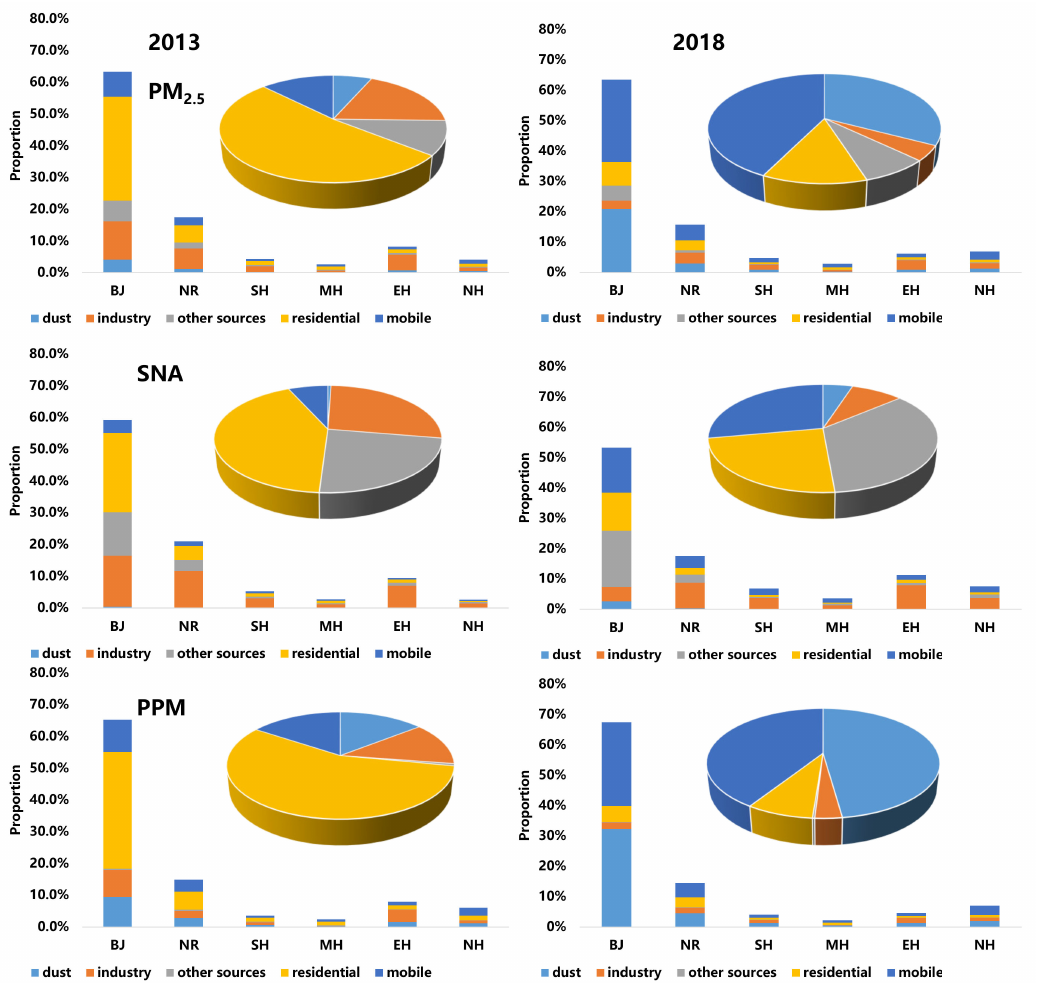
Figure 3. Source apportionment of PM 2.5 and its major components in January 2013 and 2018. Column charts representing the contribution of Beijing–Tianjin–Hebei (BTH) sources to Beijing; pie charts representing the local emission